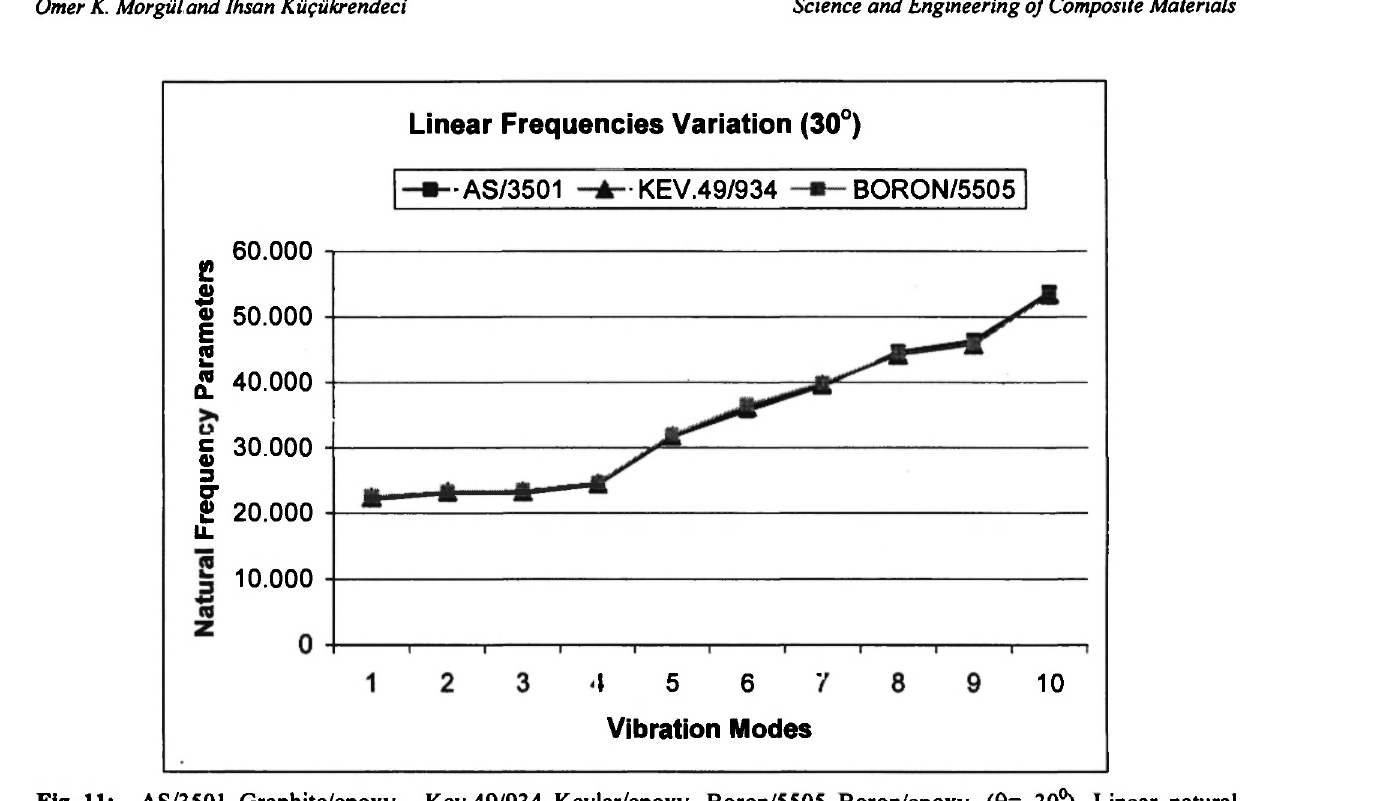
Fig. 11: AS/3501 Graphite/epoxy , Kev.49/934 Kevlar/epoxy, Boron/5505 Boron/epoxy, (θ= 30°). Linear natural frequency parameters λ of symmetrically five-layer angle-ply, square complete plates with fully clamped edges (a=0.45 m).